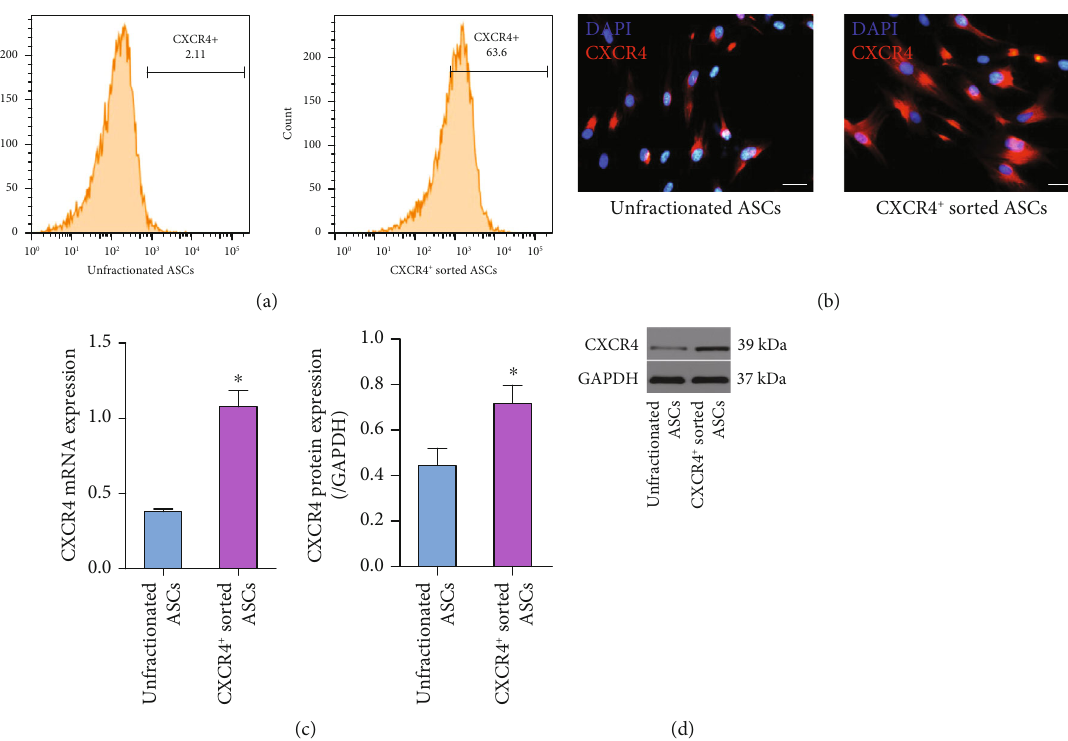
Figure 2: CXCR4 + ASCs were isolated and sorted by fl uorescence-activated cell sorting (FACS). (a) Only a minor population of CXCR4 + ASCs ( ≈ 2%) was detected in unfractionated ASCs. After sorting, CXCR4 + ASCs were enriched to approximately 63%. (b) CXCR4 (red) was highly expressed in CXCR4 + sorted ASCs by immuno fl uorescence staining. (c) The mRNA expression of CXCR4 was signi fi cantly augmented in CXCR4 + sorted ASCs relative to unfractionated ASCs by quantitative PCR. (d) CXCR4 protein (39 kDa) was more strongly expressed in CXCR4 + sorted ASCs than in unfractionated ASCs. Scale bar represents 50 μ m. ∗ p < : 05 versus unfractionated ASCs. Abbreviations: CXCR4: CXC-chemokine receptor 4; ASCs: adipose-derived stem cells; FACS: fl uorescence-activated cell sorting; GAPDH: glyceraldehyde-3-phosphate dehydrogenase, DAPI, RNA, deoxyribonucleic acid; DAPI; 4 ′